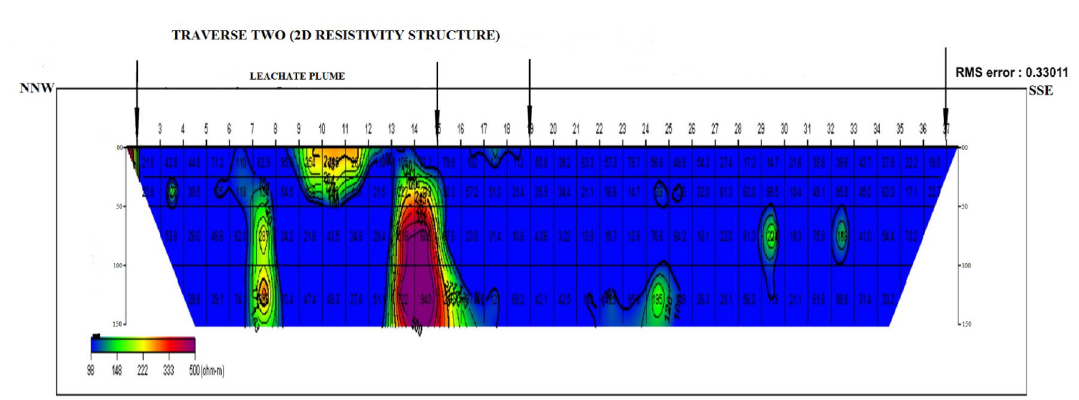
Figure 9. 2D Resistivity Structure of Traverse 1.